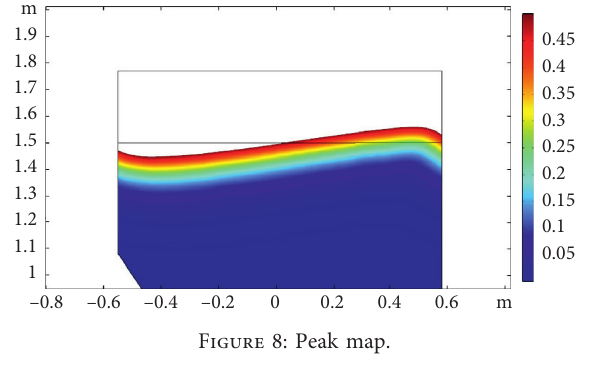
Figure 8: Peak map.